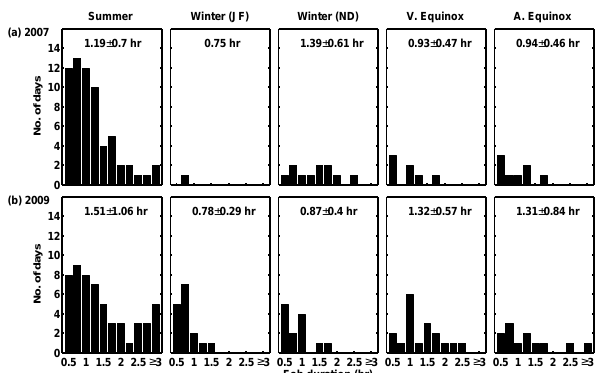
Figure 7. Seasonal number of days with E sb events as a function of duration of E sb events. Average duration of E sb along with standard deviation for each season is shown at the top in each